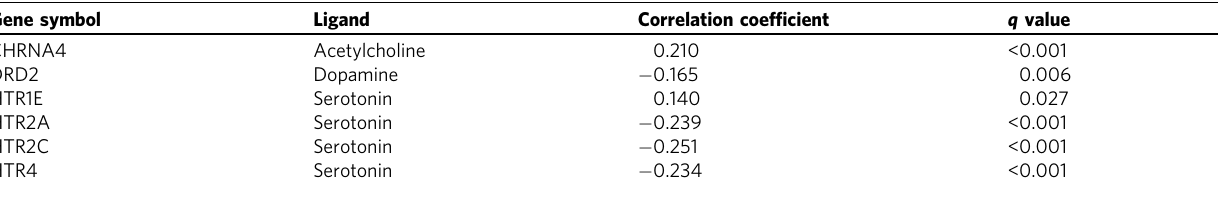
Table 3 Neurotransmitter receptor genes correlating with the change in structural – functional connectivity coupling in PD. Genes correlated with structural – functional connectivity decoupling in PD compared to controls Gene symbol